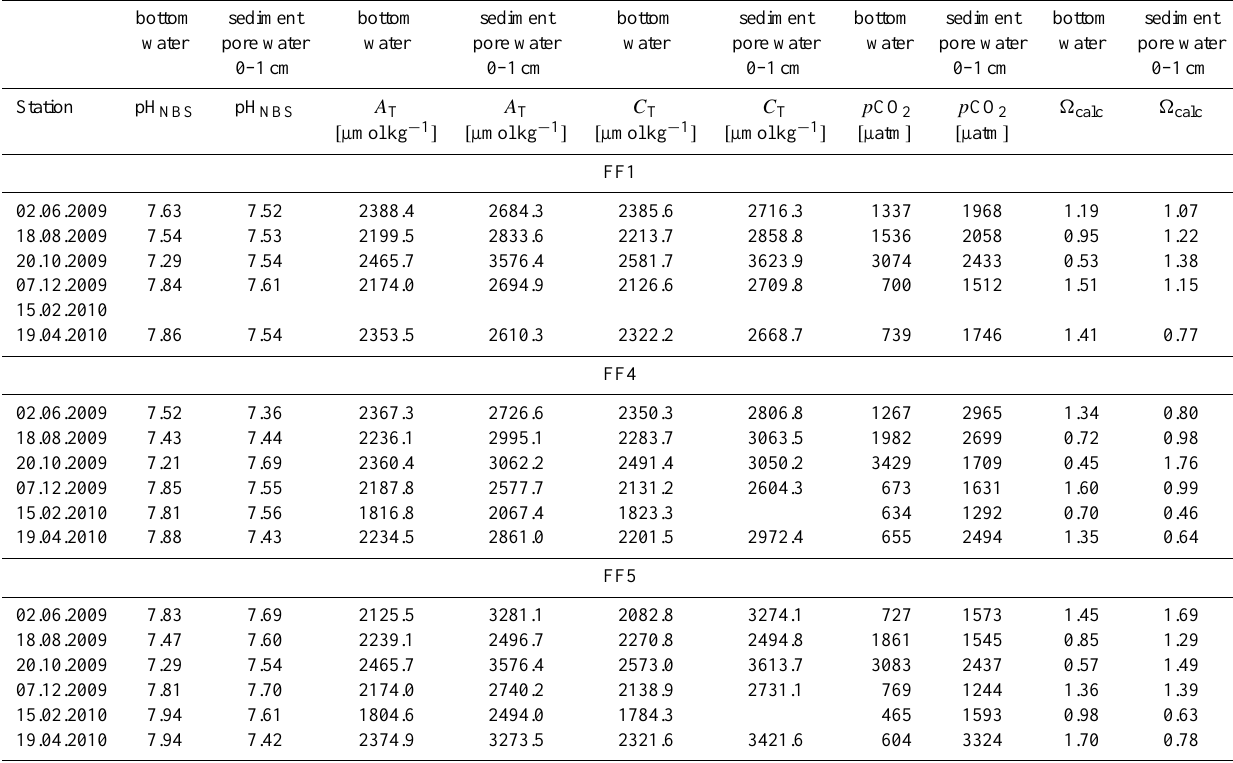
Table 4. Seawater carbonate chemistry of bottom water (1cm above the sediment surface) and sediment sediment pore water (0–1cm) at stations FF1, FF4 and FF5 during the one year cycle. Bottom and sediment pore water pH NBS were measured using a WTW 340i. Total alkalinity ( A T ) was determined with a Metrohm titration instrument. Dissolved inorganic carbon ( C T ), carbon dioxide partial pressure ( p CO 2 ), and omega calcite ( (cid:127) calc ) were calculated using the CO2Sys-software.